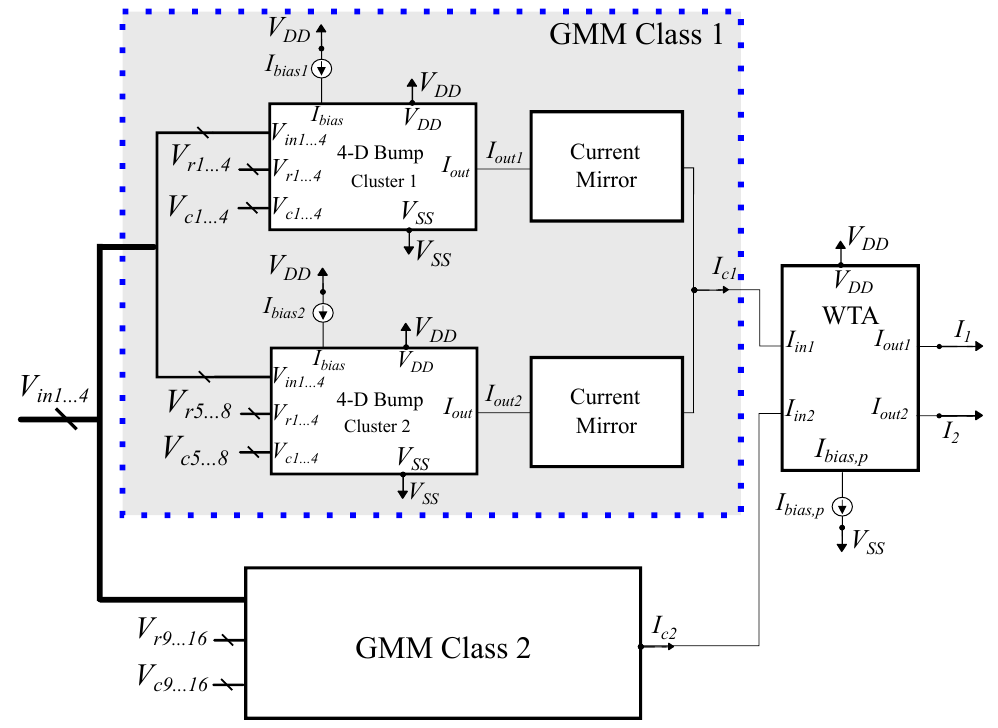
Figure 6. Analog GMM-based classifier with two classes, two clusters per class, and 4D inputs (four input features). ( left ) GMM class with two clusters; ( right ) WTA circuit. GMM class 2 follows the same architecture as the depicted GMM class